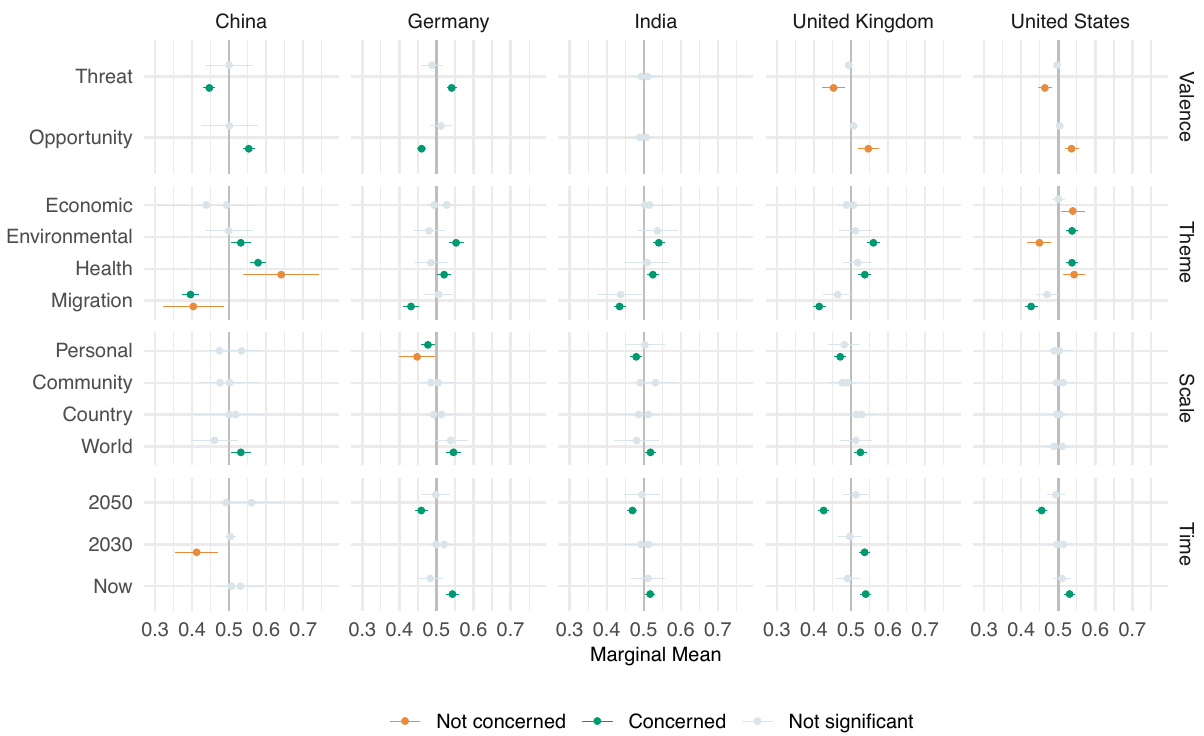
Fig. 3 Effects of different climate frames on support for climate policies for respondents concerned about climate change and respondents not concerned about climate change for individual countries. Sample size: China n = 1502, Germany n = 1501, United Kingdom n = 1500, India n = 1506, United States n = 1503. Data are weighted to be nationally representative. Fieldwork by Deltapoll, October 2020. Question: Respondents were shown two statements in which the valence, theme, scale, and time frame were varied at random, providing 96 possible permutations. Respondents were asked: Indicate which of the two statements would make you more likely to support policies to tackle climate change. Dots with horizontal lines indicate marginal means with 95% con fi dence intervals